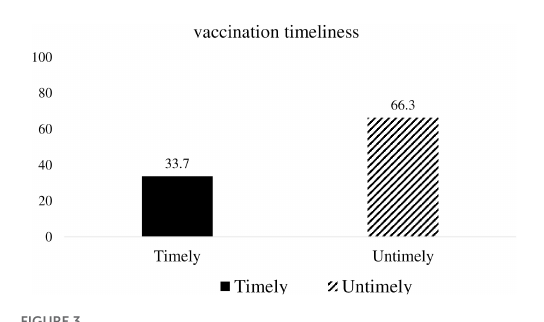
TABLE 4 Access-related factors for vaccination timeliness and associated factors among children aged 12–23 months in Debre Libanos district North Shewa Zone, Oromia Regional State, Ethiopia 2021.